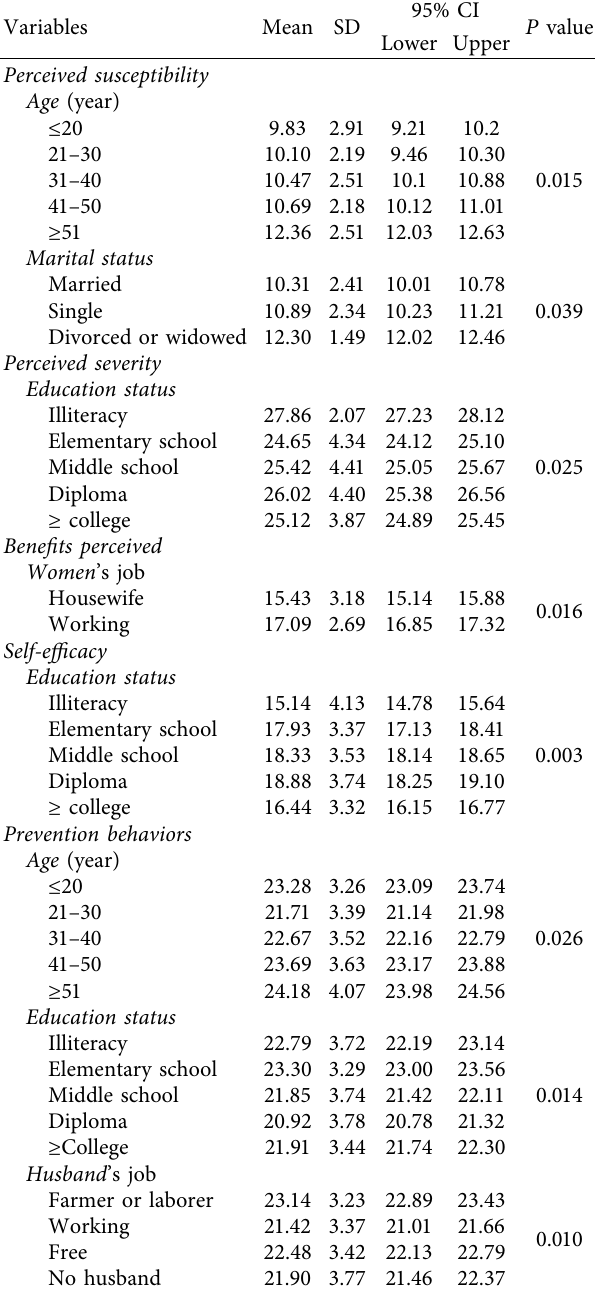
Table 4: Te relationship of Health Belief Model with demographic and background characteristics ( n � 289).